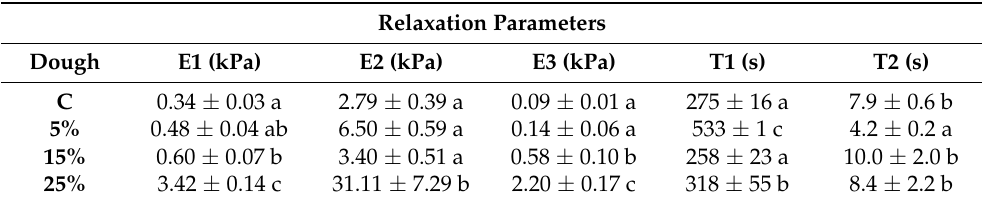
Table 5. Parameters from relaxation curves of dough: wheat flour (control: C) and blends of wheat flour and oat flour at levels of 5, 15, and 25%.